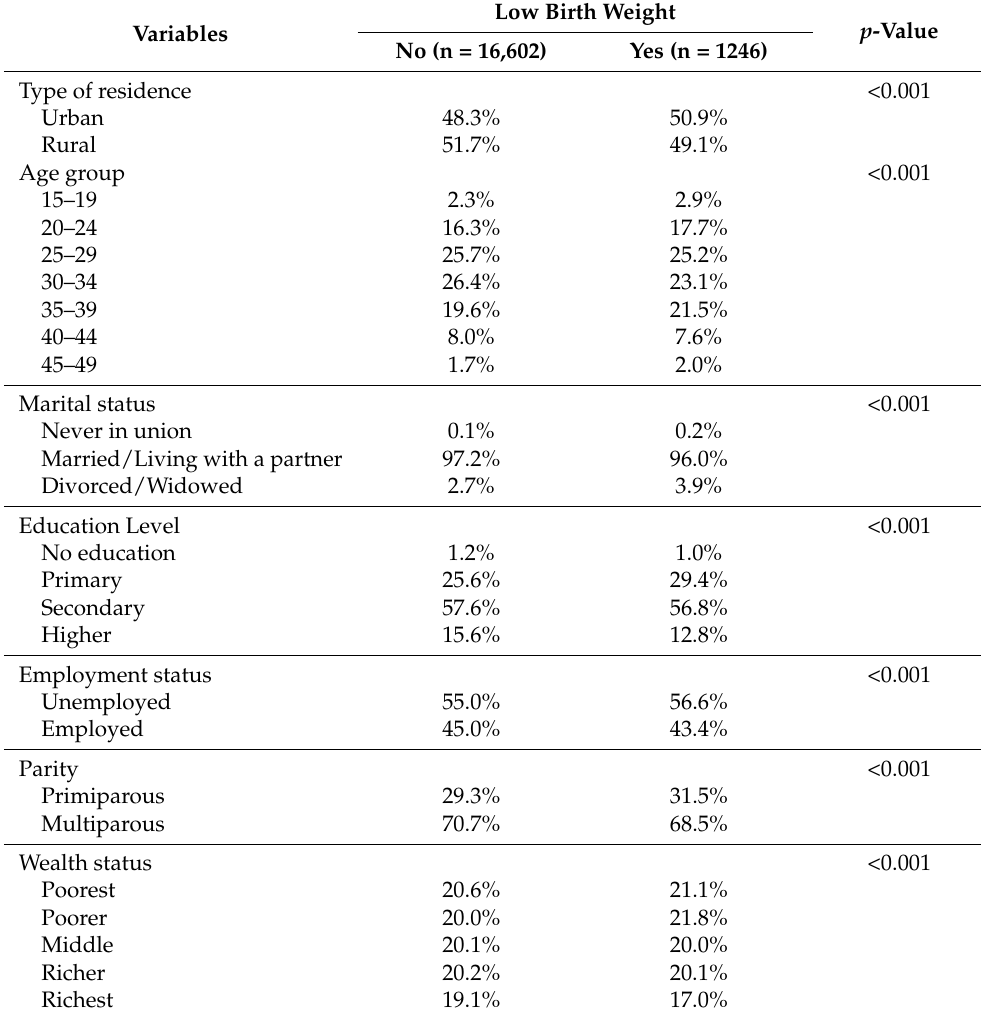
Table 1. The descriptive analysis of LBW in Indonesia,